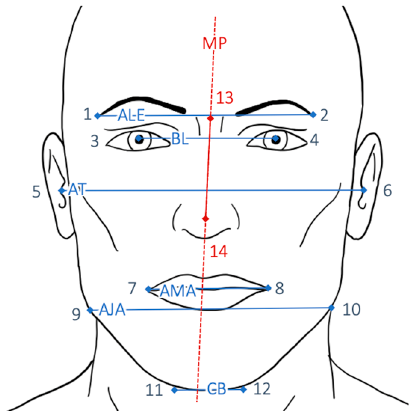
Figure 6. Photographic landmarks and axes as described in Table 2. Ideally the vertical midfacial plane (MP) should be perpendicular to all six axes axis of lateral eyebrows (ALE), bipupillary line (BL), axis of tragi (AT), axis of mouth angle (AMA), axis of jaw angles (AJA), and chin base (CB). Midfacial plane is defined as the axis between the glabella (13) and the tip of the nose (14) and represents a continuous perpendicular to the horizontal facial planes. Table 2. Axes between two defined points (see Figure 6). Six angles between each axis and the mid- facial plane are determined.